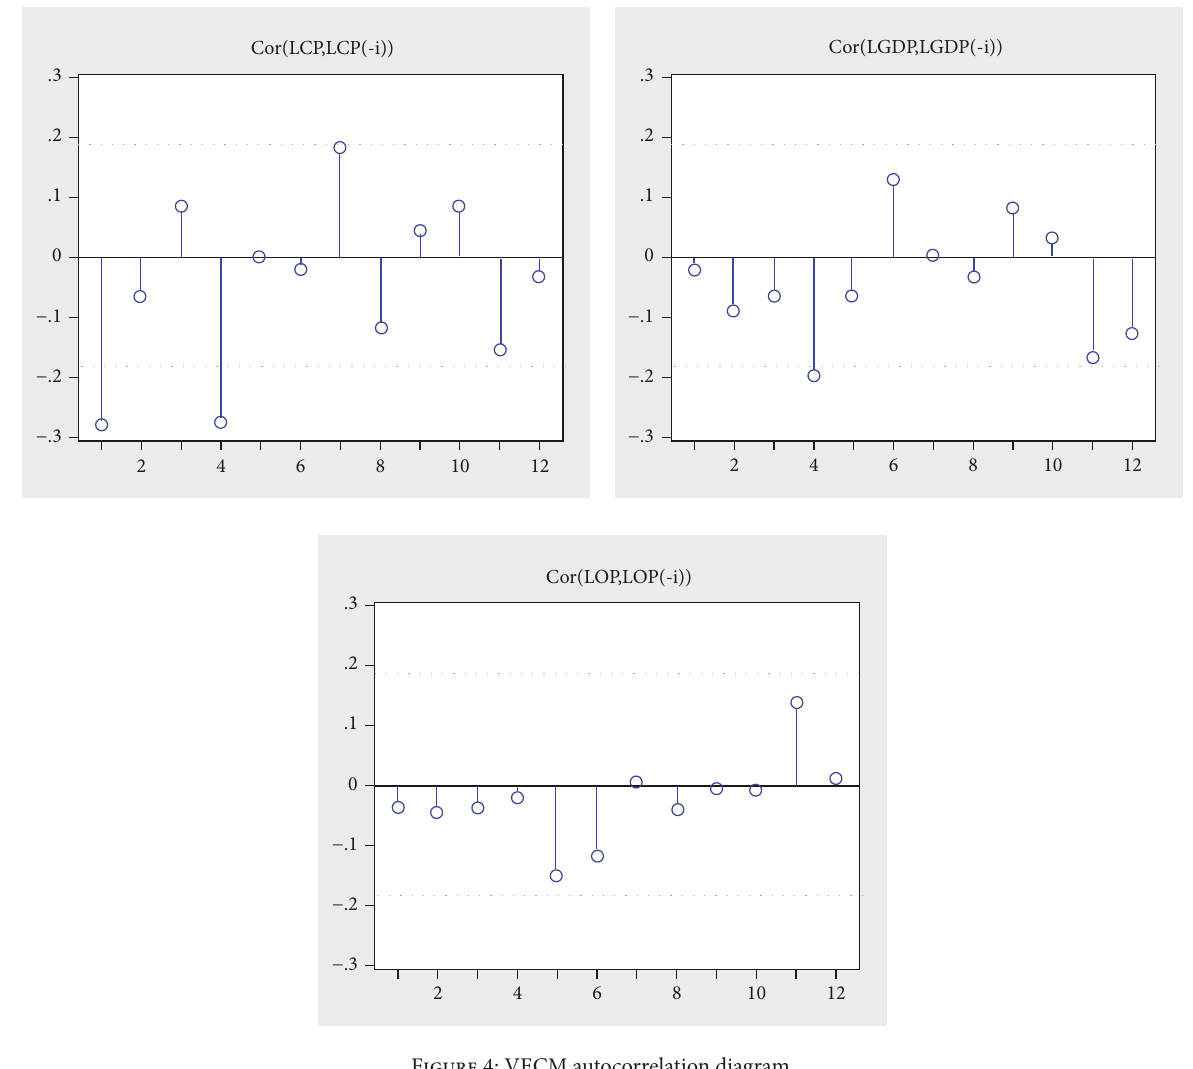
Figure 4: VECM autocorrelation